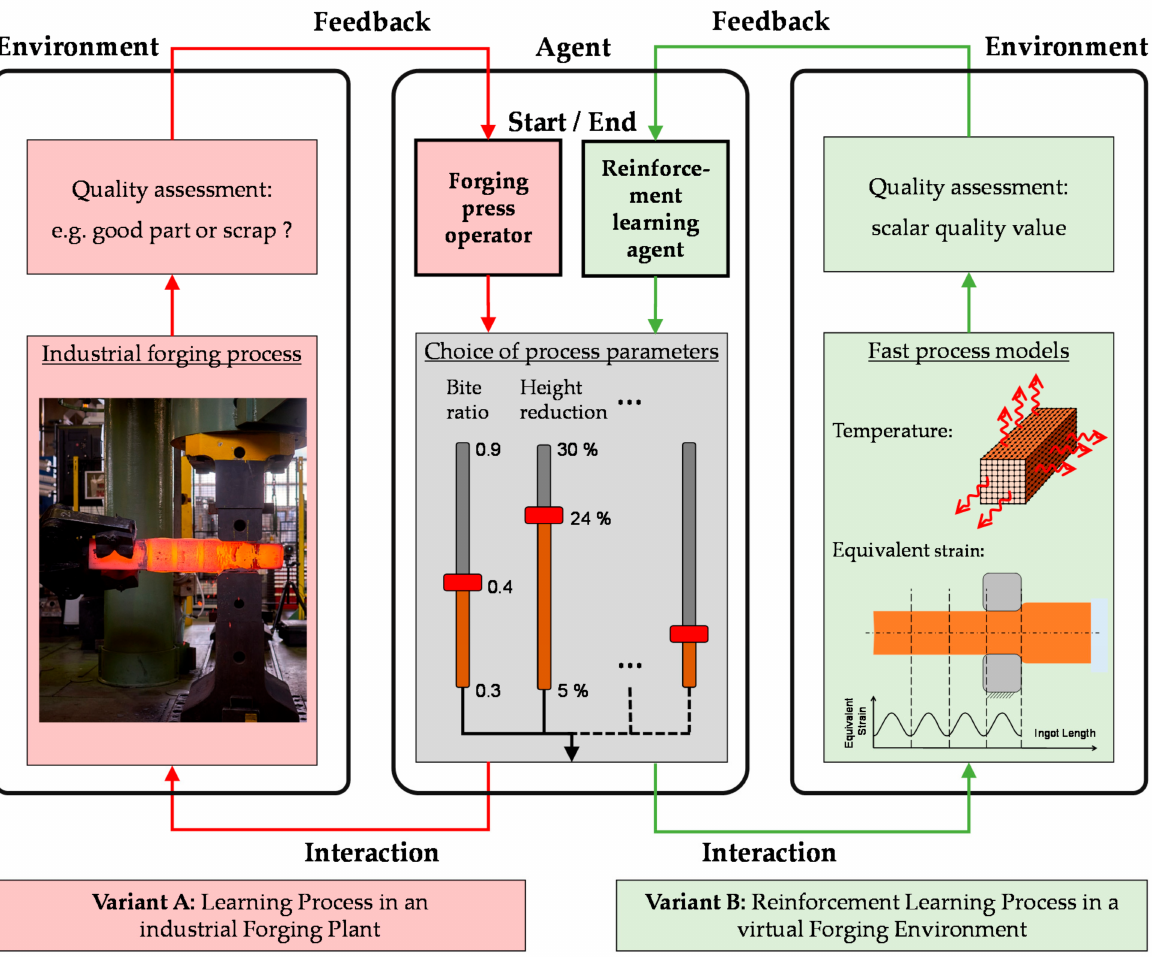
Figure 3. Schematic diagram of learning through interaction and feedback. Variant A, red: learning process in an industrial forging plant; variant B, green: reinforcement learning in a virtual forging